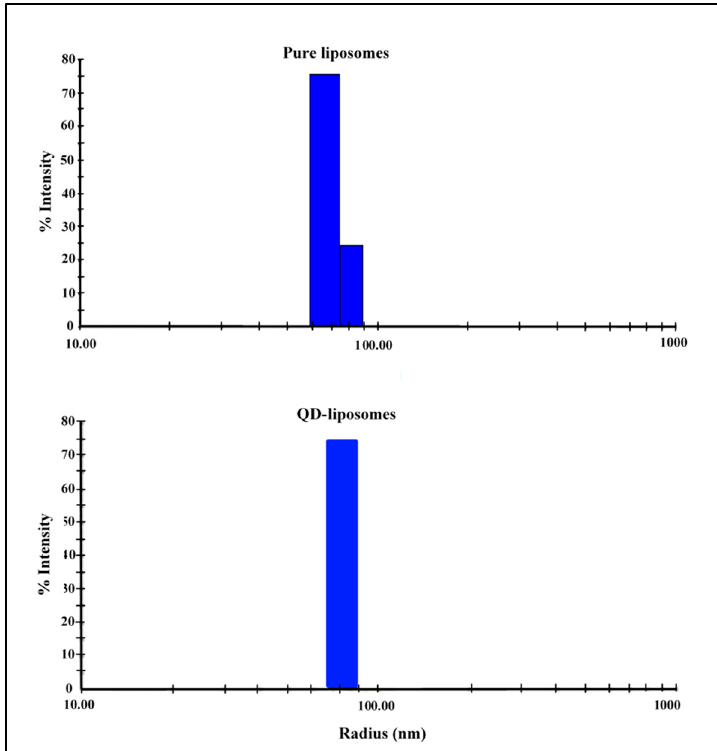
Figure 2. Size distributions of pure liposomes and QD ‐ liposomes.